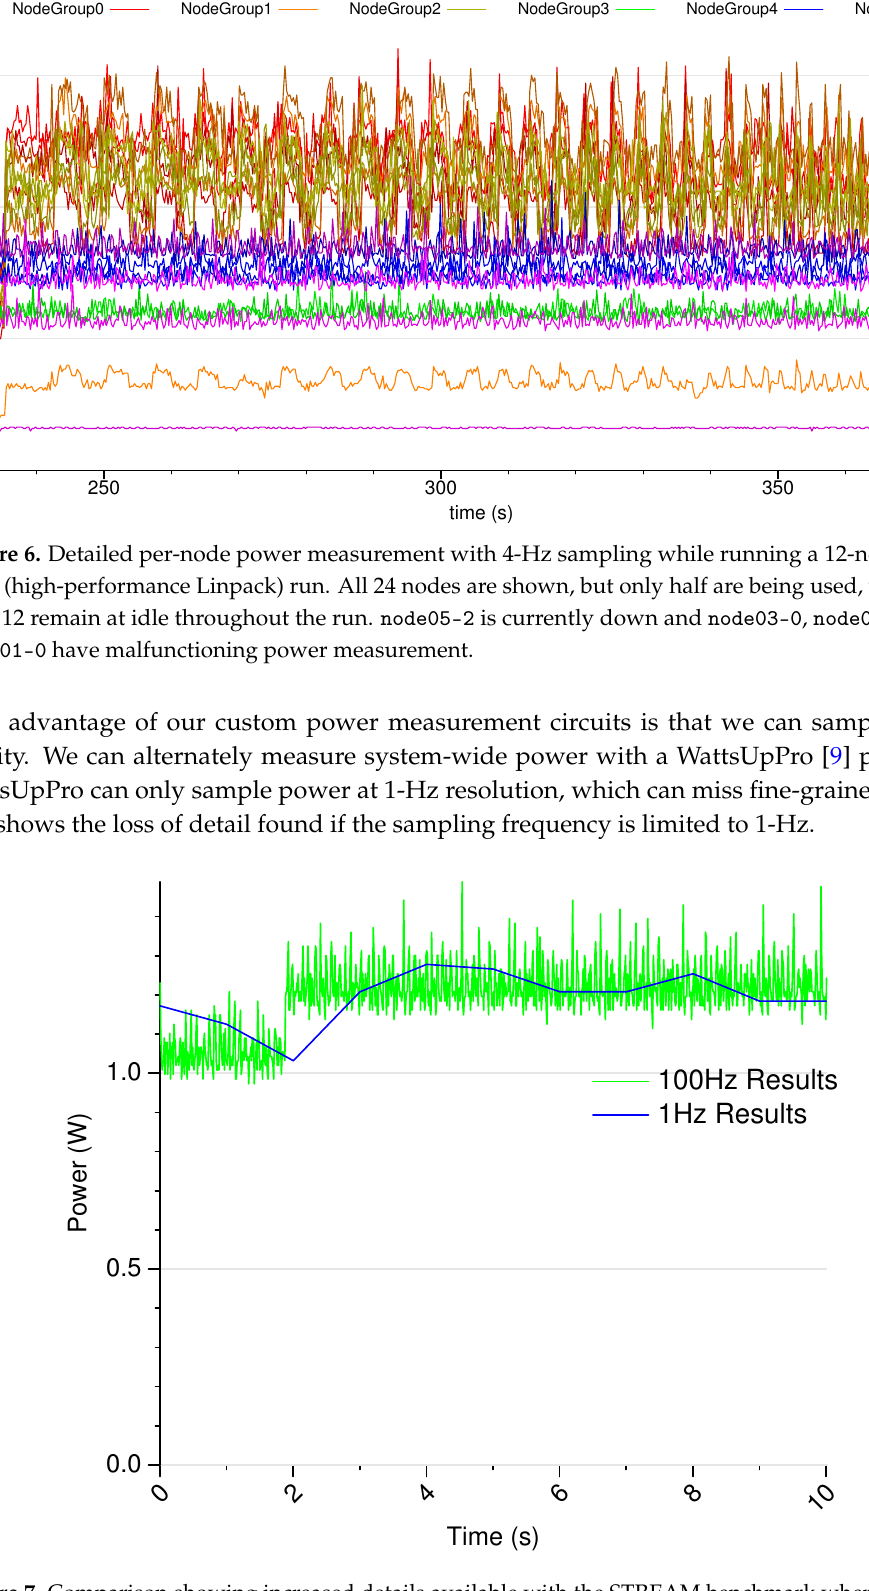
Figure 7. Comparison showing increased details available with the STREAM benchmark when using a higher sample rate of 100 Hz vs. the 1-Hz sampling available with a WattsUpPro